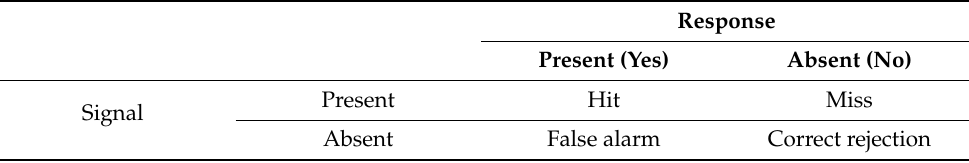
Table 2. The four typical situations of the signal detection